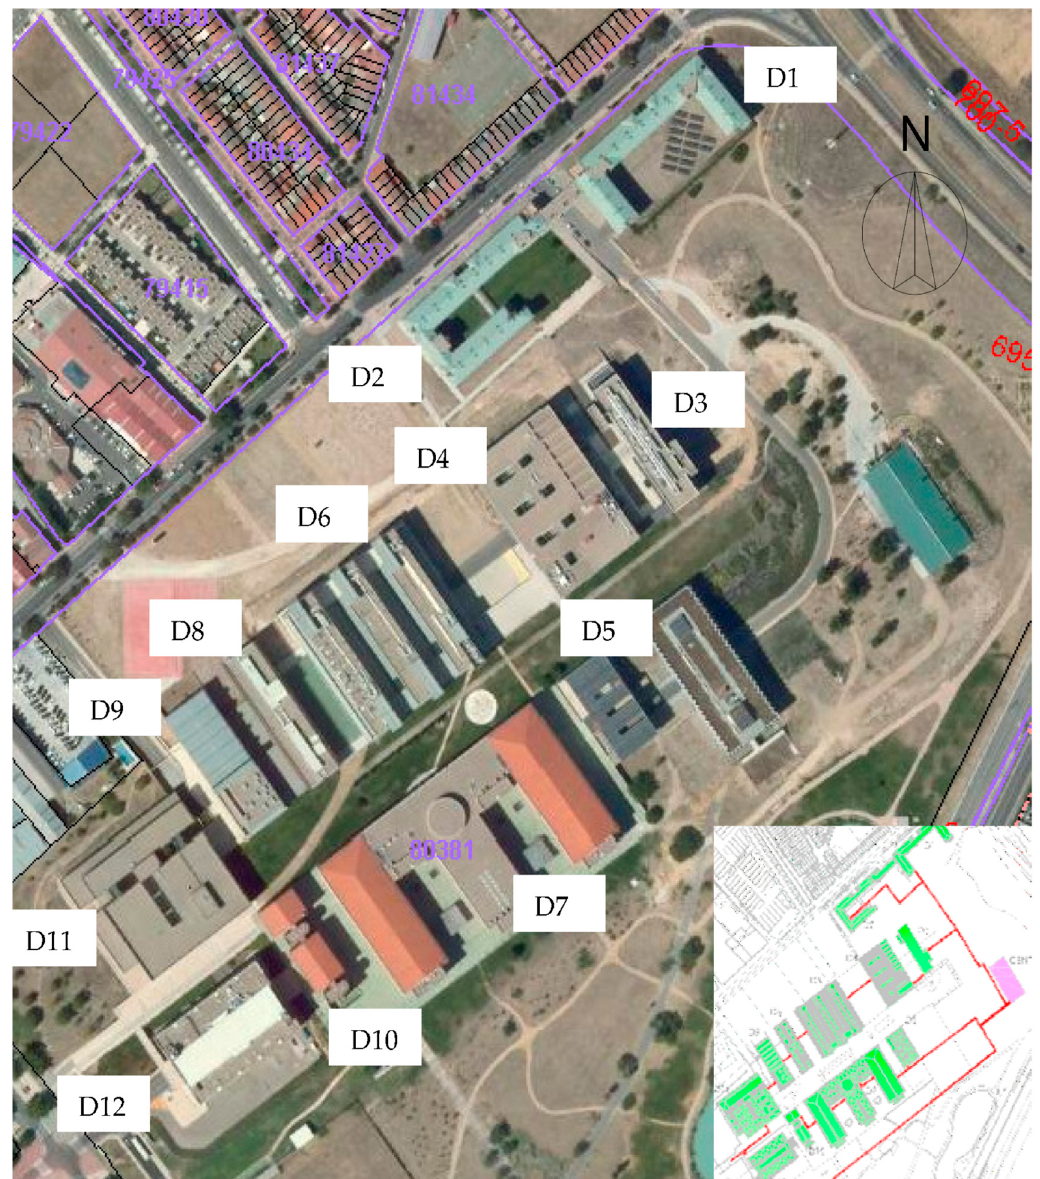
Figure 1. Miguel Delibes Campus. Buildings connected to district heating (DH).